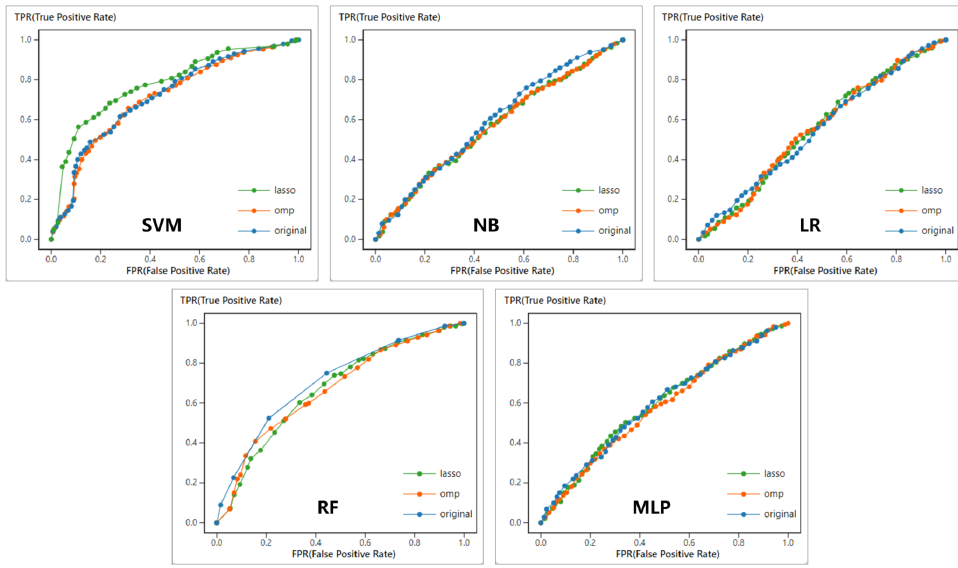
Figure 5. ROC curve for five classification